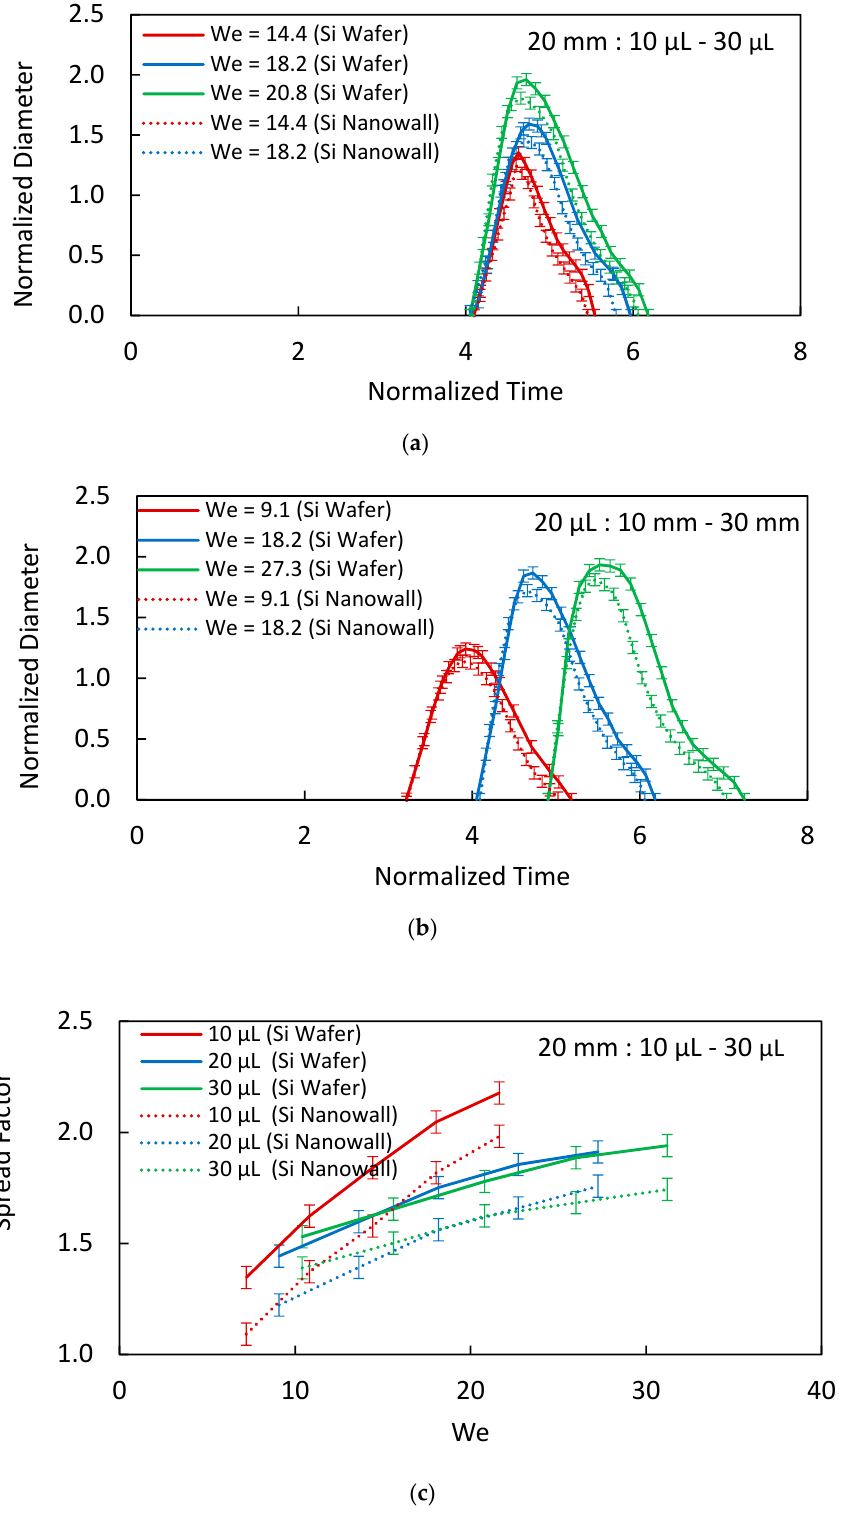
Figure 6. ( a ) Normalized spreading diameter variation with normalized time for 20 mm height and 10–30 μ L droplet volumes. ( b ) Normalized spreading diameter variation with normalized time for 20 μ L and 10–30 mm impact heights. ( c ) Spread factor variation with Weber number for 20 mm height and 10–30 μ L droplet volumes.